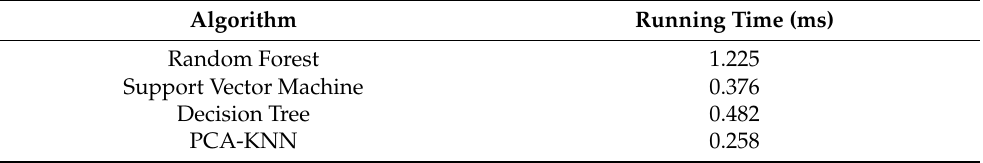
Table 5. Comparison of running time of different algorithms.